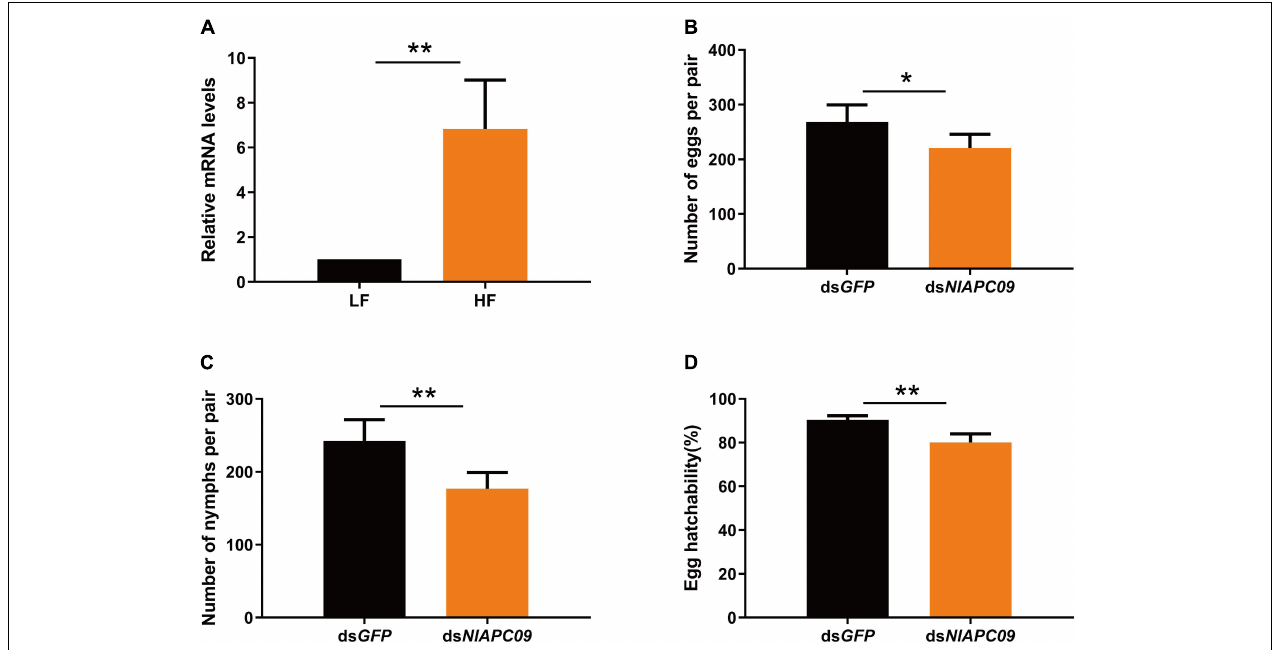
FIGURE 6 | The determination on the role of NlAPC09 in regulating fecundity in BPHs. (A) Relative expression levels of NlAPC09 in the ovaries of BPHs from the high-fecundity and the low-fecundity population as evaluated by qPCR. HF, high-fecundity population; LF, low-fecundity population. The effect of silencing NlAPC09 expression on the egg laying amount (B) , the nymph number (C) , and egg hatchability (D) in BPHs. Student’s t -test was used to compare the difference in the mRNA level of NlAPC09 between different populations and in the fecundity parameters between different treatments (* P < 0.05; ** P <